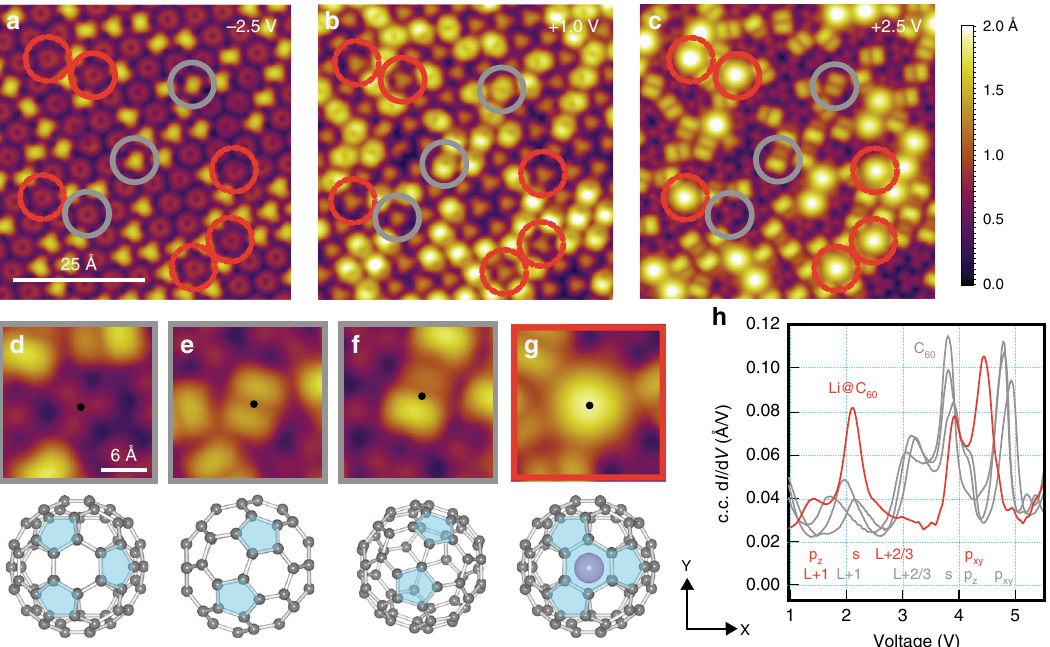
Fig. 2 Representative STM images of C 60 /Li@C 60 on Au(111), and C 60 versus Li@C 60 discrimination. a – c STM images of the same area acquired at varying tunnelling biases: a – 2.5 V, 0.1 nA; ( b ) + 1 V, 0.1 nA; ( c ) + 2.5 V, 0.1 nA. d M-C 6 fullerene (adsorbed through a hexagonal face). e C 6 – C 6 fullerene (adsorbed through a C = C double bond joining two C 6 faces). f Apex fullerene (adsorbed on a C atom adjoining two C 6 and one C 5 faces). g Li@C 60 (always adopting the C 6 adsorption orientation). Images d – g obtained for + 2.5 V. h Constant-current d I /d V spectra from the four different molecular features seen in d –